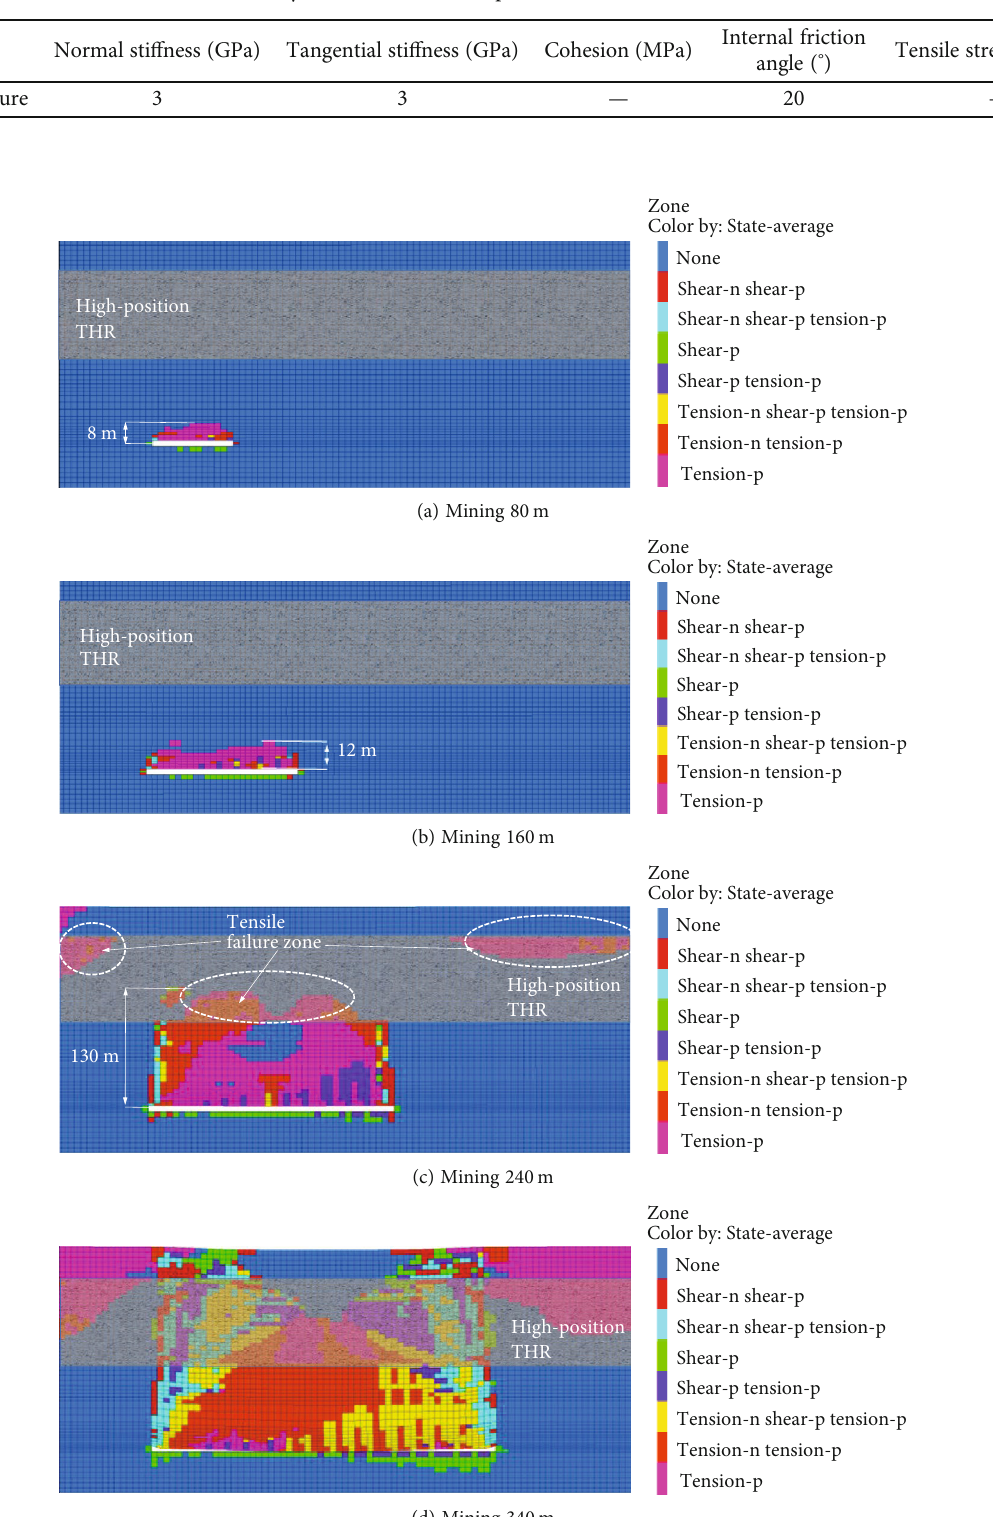
Figure 8: Plastic zone change during